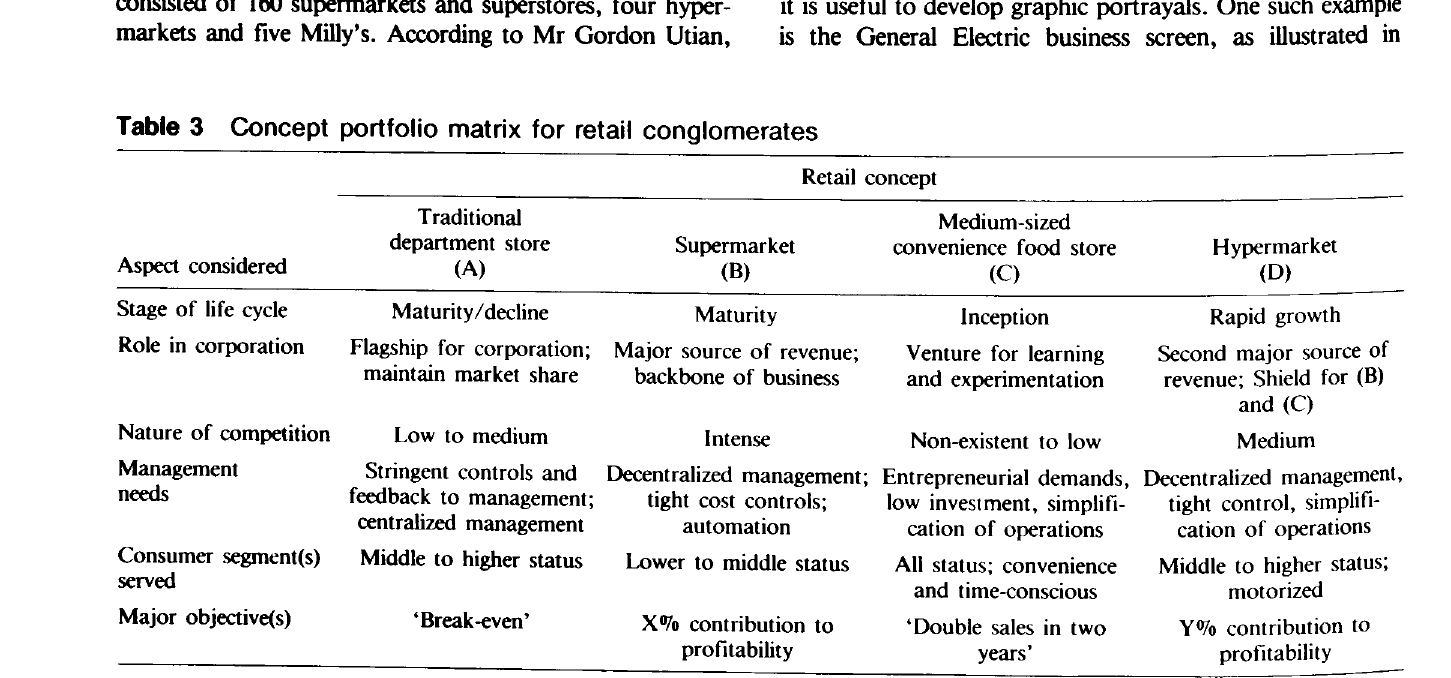
Concept portfolio matrix for retail